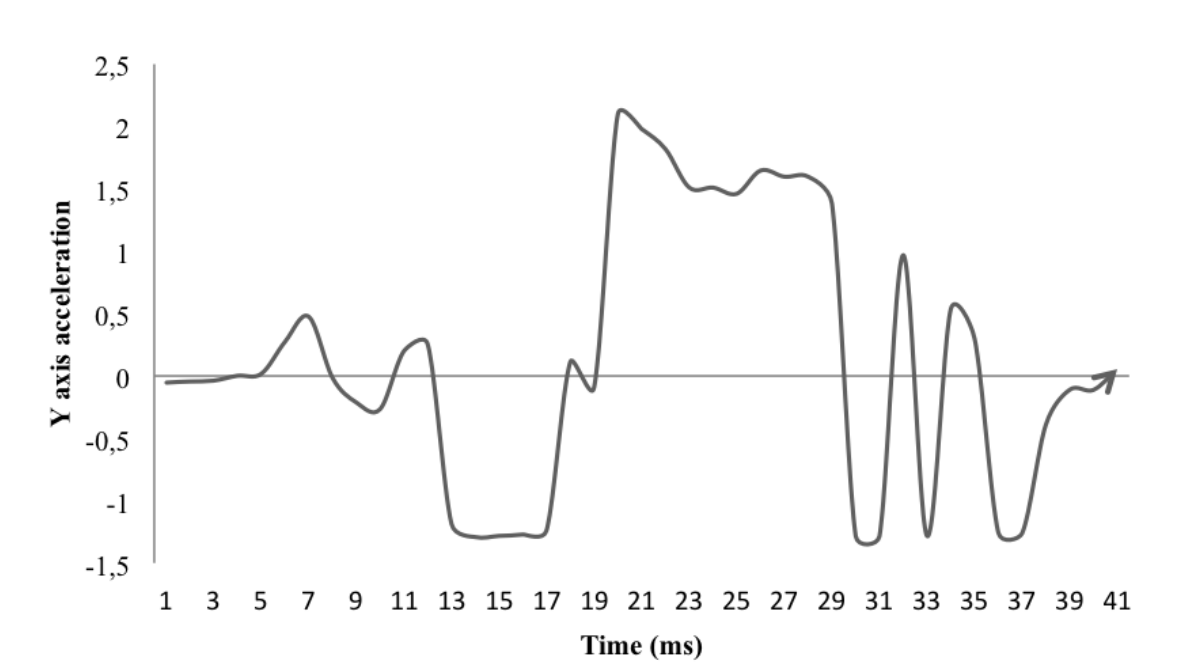
Figure 2. CMJ Y axis acceleration graphic